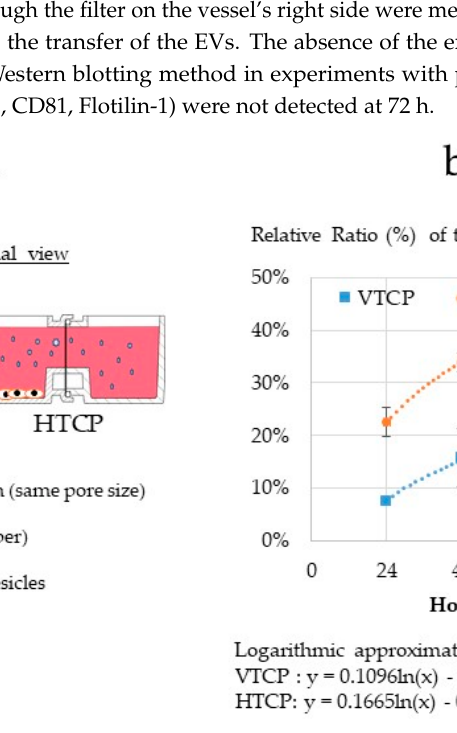
Figure 7. Validation of the ability of extracellular vesicles (EV) to pass through the filter according to co-culture type. ( a ) Scheme of the evaluation method for EVs secreted from PANC-1 cells. ( b ) Evaluation of the passing ability of extracellular vesicles (EV) secreted from cells. The same number of PANC-1 cells was seeded on one side of the horizontal-type co-culture plate (HTCP) and vertical-type co-culture plate (VTCP). The number of EVs passing through the filter was measured by Nanosight. The number of EVs per ml was then calculated. The EV density on the cell side was set to 100%. The HTCP contained three times the density of EVs per cell at 24 h, two times at 72 h, compared to the VTCP, demonstrating the high efficiency of the HTCP for EV